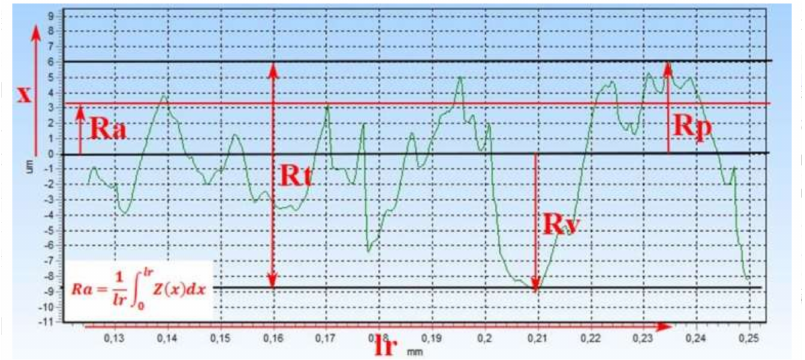
Figure 4. Surface Roughness profile drilled with Brad Spur drill bit at 5000 rpm and at 0.05 mm/rev.